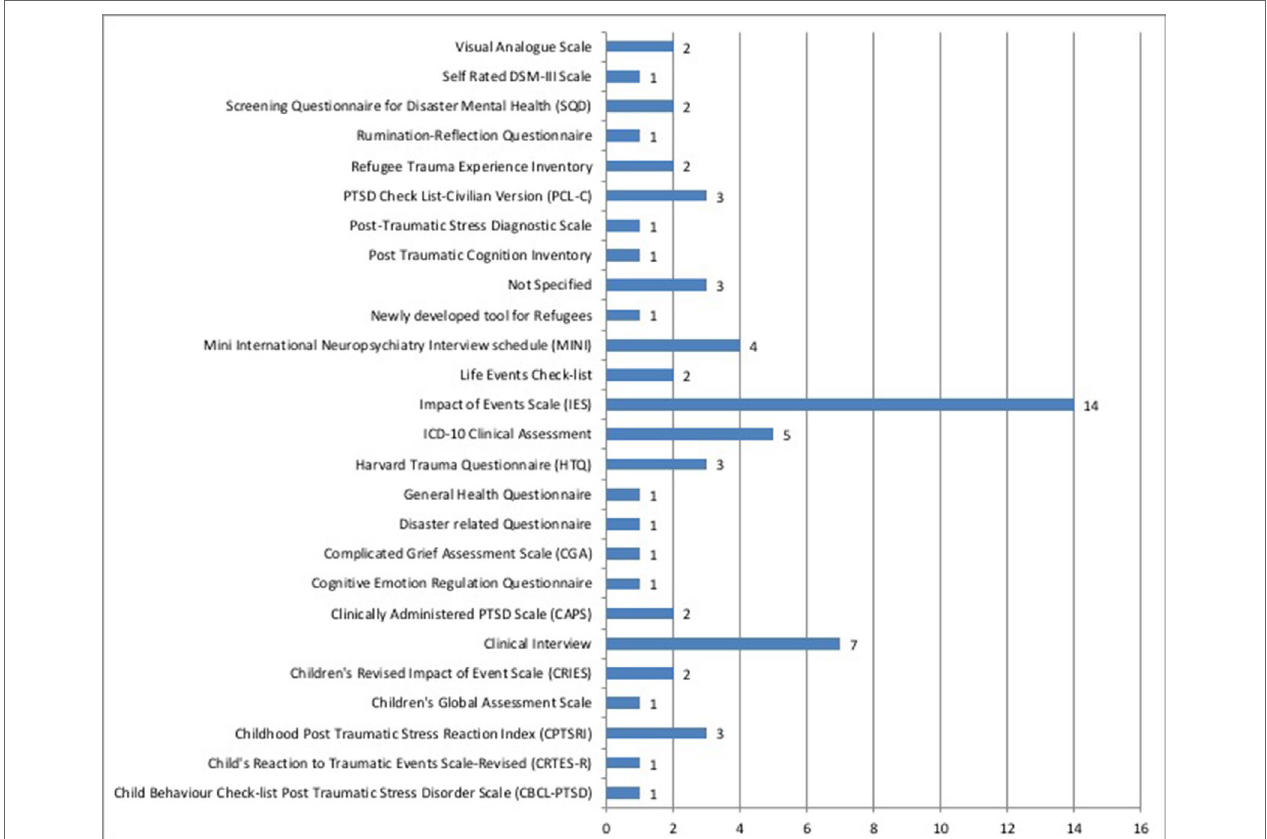
FIGURE 5 | Types of measures for screening and diagnosis applied and the number of studies that used